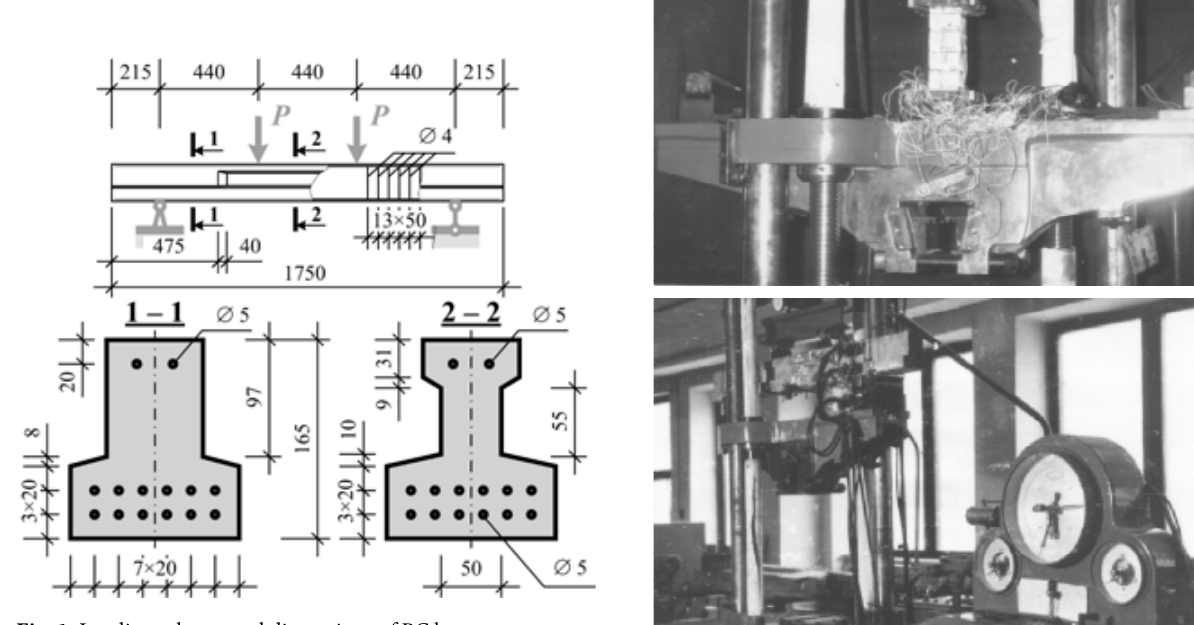
Fig. 1. Loading scheme and dimensions of PC beams